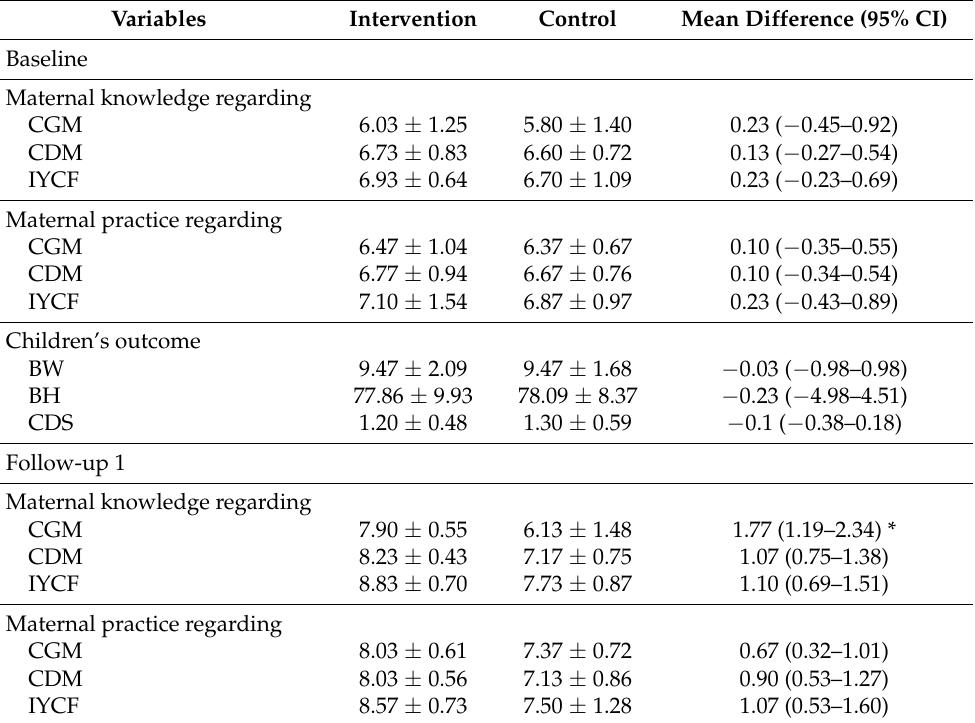
Table 2. Association between intervention and research outcome among different times.